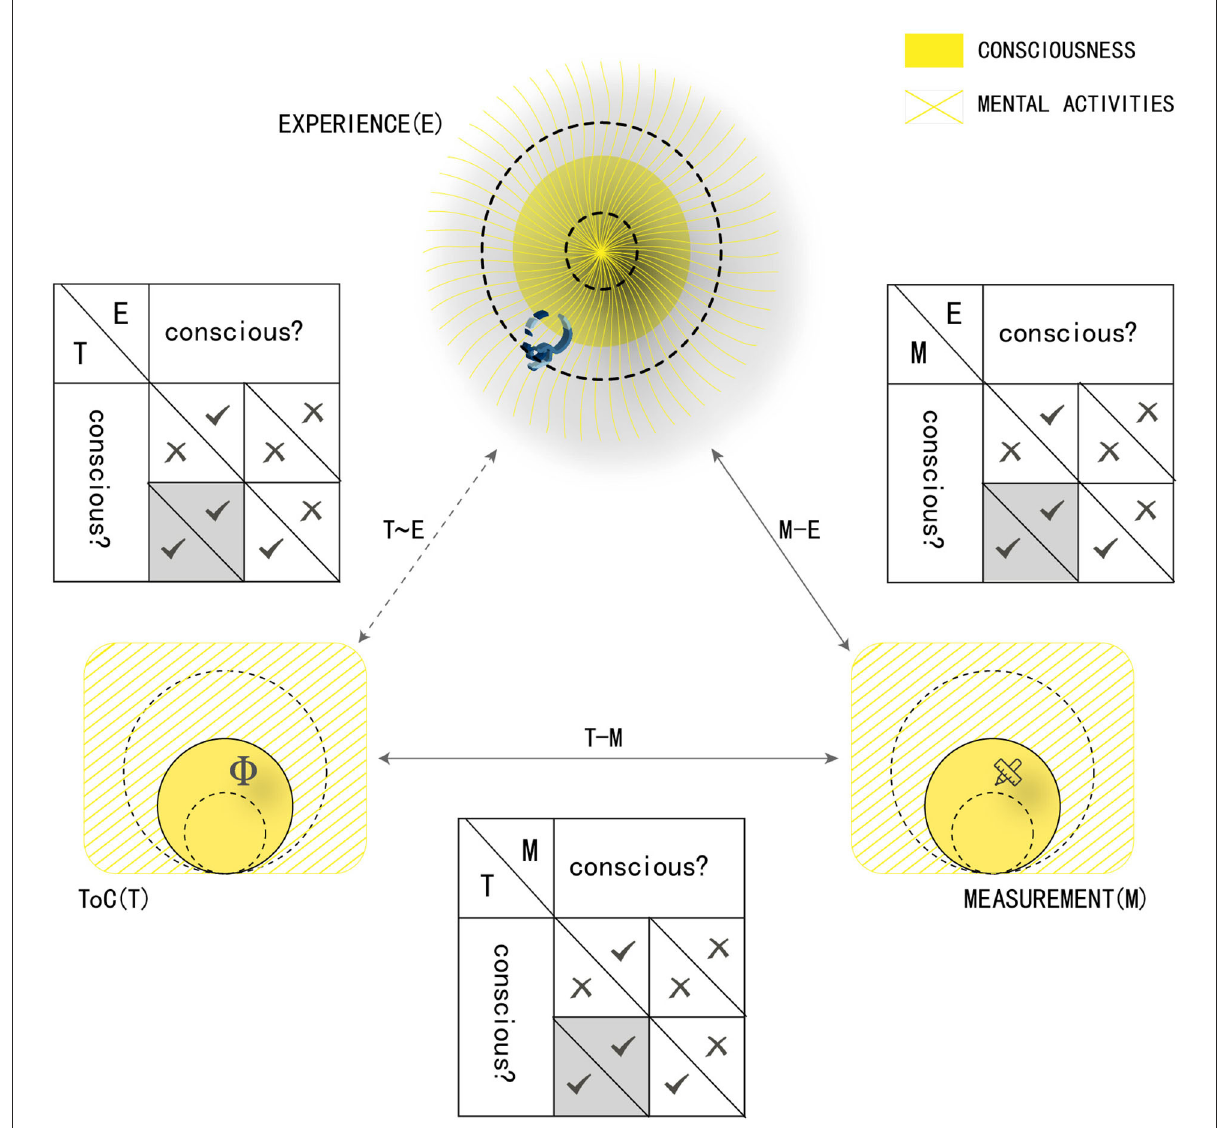
FIGURE1 The N–S criterion of ToCs. (1) The general: A “proper” ToC specifies a model identical to consciousness, whose “necessity” is to get a fairly “wide” scope covering all the mental activities and whose “sufficiency” is to contain a “narrow” enough scope of those mental activities (see bottom left , ToC, denoted as T). Both the “wide” and the “narrow” are shown by dashed circles, while the filled portion within the solid circles is the necessary and sufficient region. (2) The specific: Similarly, the experience itself ( top , denoted as E) and the measurement ( bottom right , denoted as M) also get in the proper scope of where the consciousness is located throughout the mental activity. E is considered proper a priori and the identity between T and E (T ∼ E, ∼ for a transcendental relation) is the goal of the traditional philosophical approaches. Theoretically, only one (gray-filled) of the four underlying relations between them can meet the N–S criterion. For empirical tests, three levels of the N–S criterion (T–M, M–E, and then T–M–E) are a must and each of level would constrain the corresponding procedure of the ToC tests